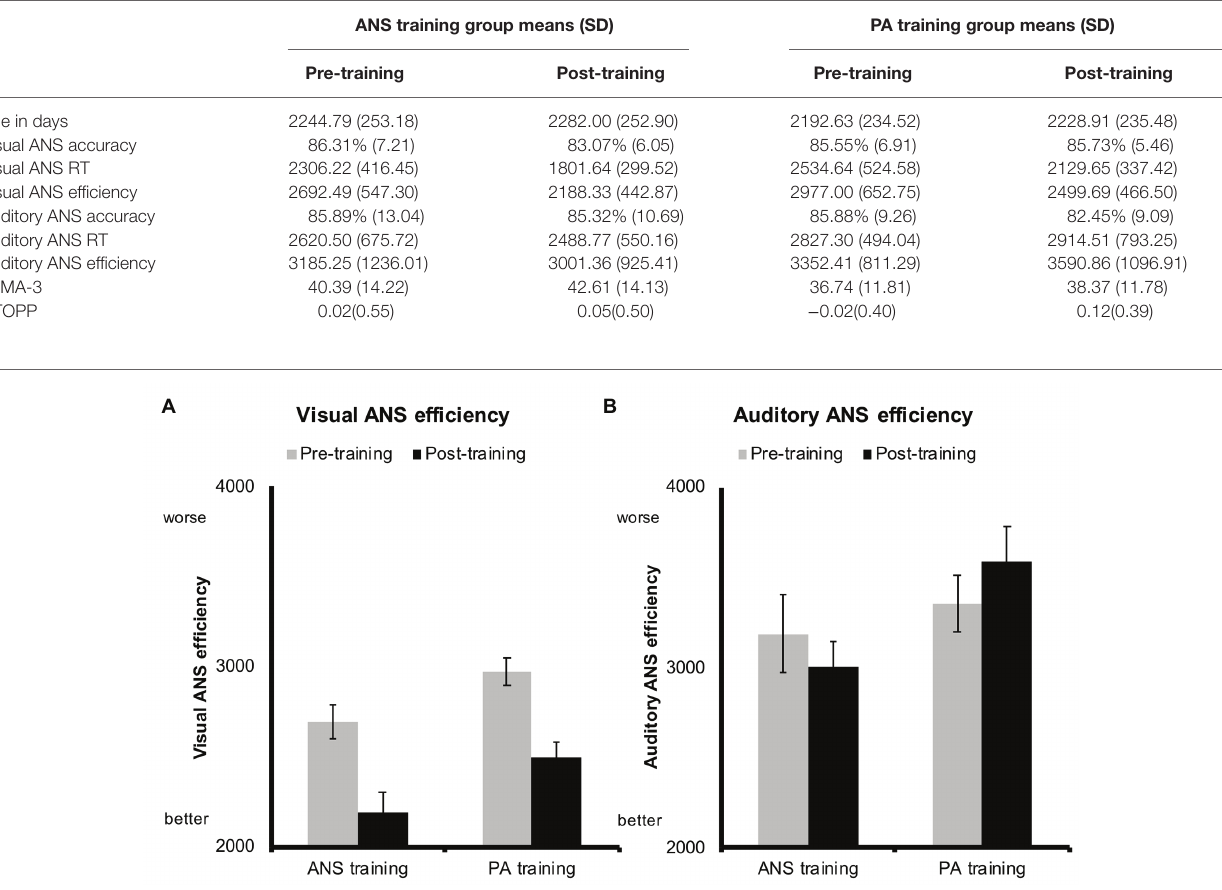
TABLE 3 | Pre-training and post-training scores for the visual and auditory ANS precision tasks, math ability (raw scores on the TEMA-3), and phonological awareness (composite z -score on the CTOPP), presented separately for the two training